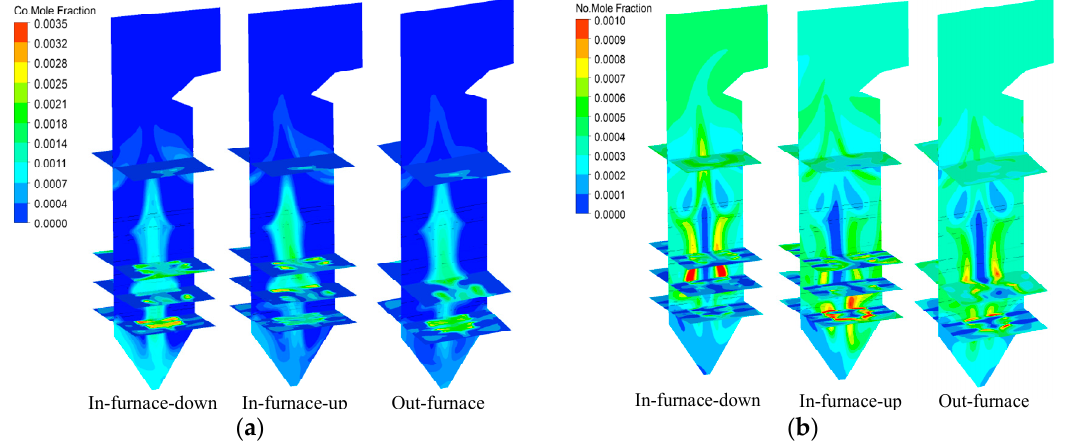
Figure 9. The contours in furnace under various injection strategies of semi-coke; ( a ) the mole fraction of CO; ( b ) the mole fraction of NO.